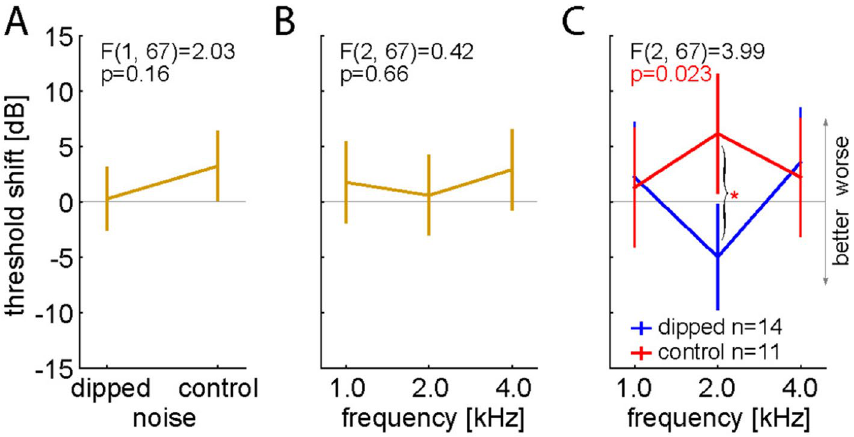
Figure 1. Long-term dipped noise exposure induced improvement of hearing thresholds. Two-factorial ANOVA results of hearing threshold shifts with factors noise and frequency. ( A , B ) Non-significant one- factorial analysis parts of noise ( A ) and frequency ( B ). ( C ) Significant interaction of both factors. Animals treated with 2 kHz spectral dipped noise (n = 14) show a significant (p = 0.028, Tukey post-hoc test) mean decrease (= improvement) of hearing thresholds at 2 kHz compared to control (n = 11) animals’ hearing thresholds. The hearing thresholds for 1 and 4 kHz (flat spectrum) do not show significant differences between the groups. Error bars indicate 95% confidence intervals.